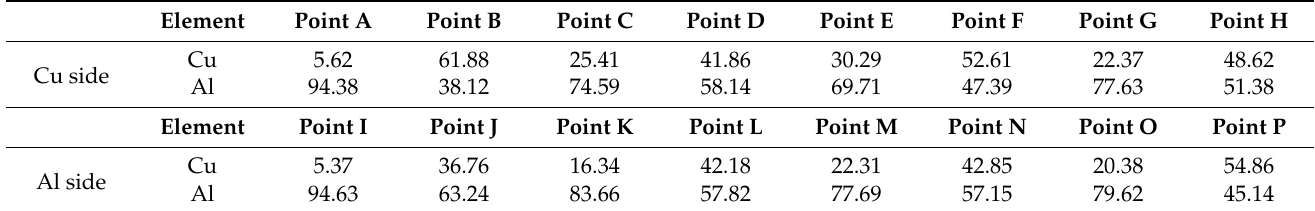
Table 6. The element contents of Cu and Al by point scanning of peeled section at trough